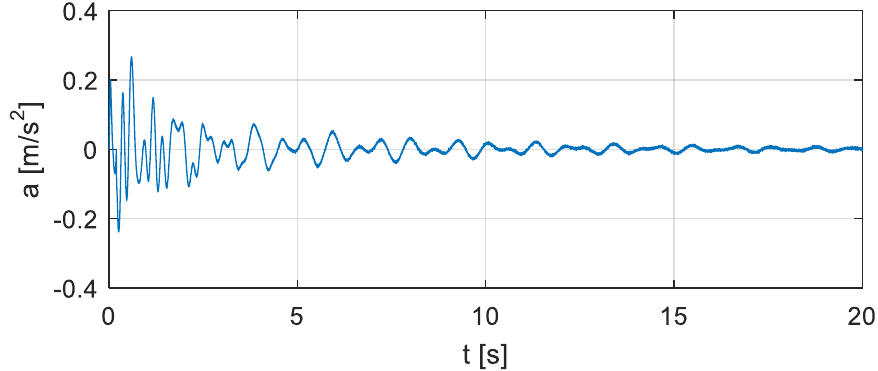
Figure 14. Vertical acceleration of the bridge at the location of the vehicle.